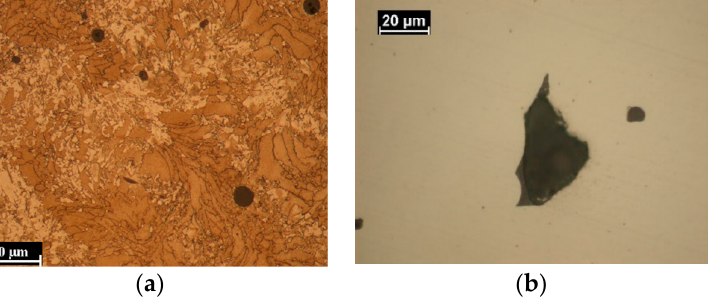
Figure 7. Optical micrographs of the T section of the D d1 sample showing ( a ) unmelted powders in the etched section and ( b ) unmelted powder associated with the void in the as polished T section.